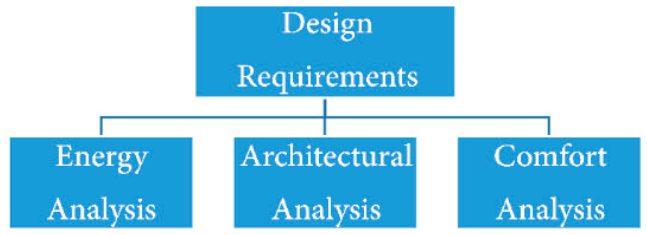
Figure 4. Design requirements for sustainable construction.